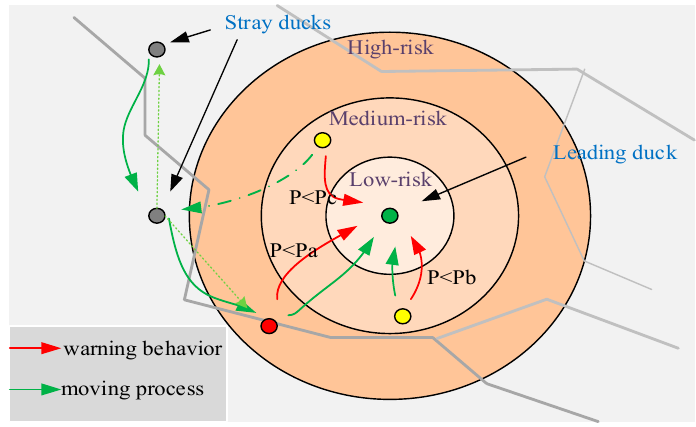
Figure 1. The warning behavior and the moving process of anas platyrhynchos swarm.